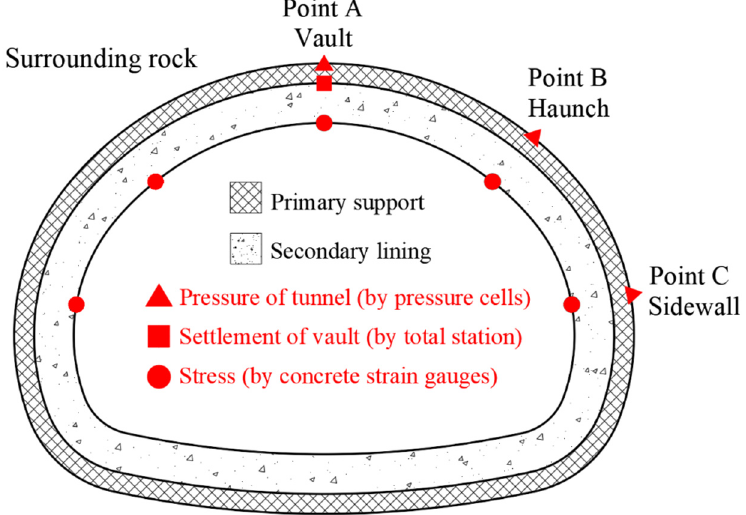
Figure 5. The measure points of Daling Tunnel. Three items were observed in the field measure- ment.